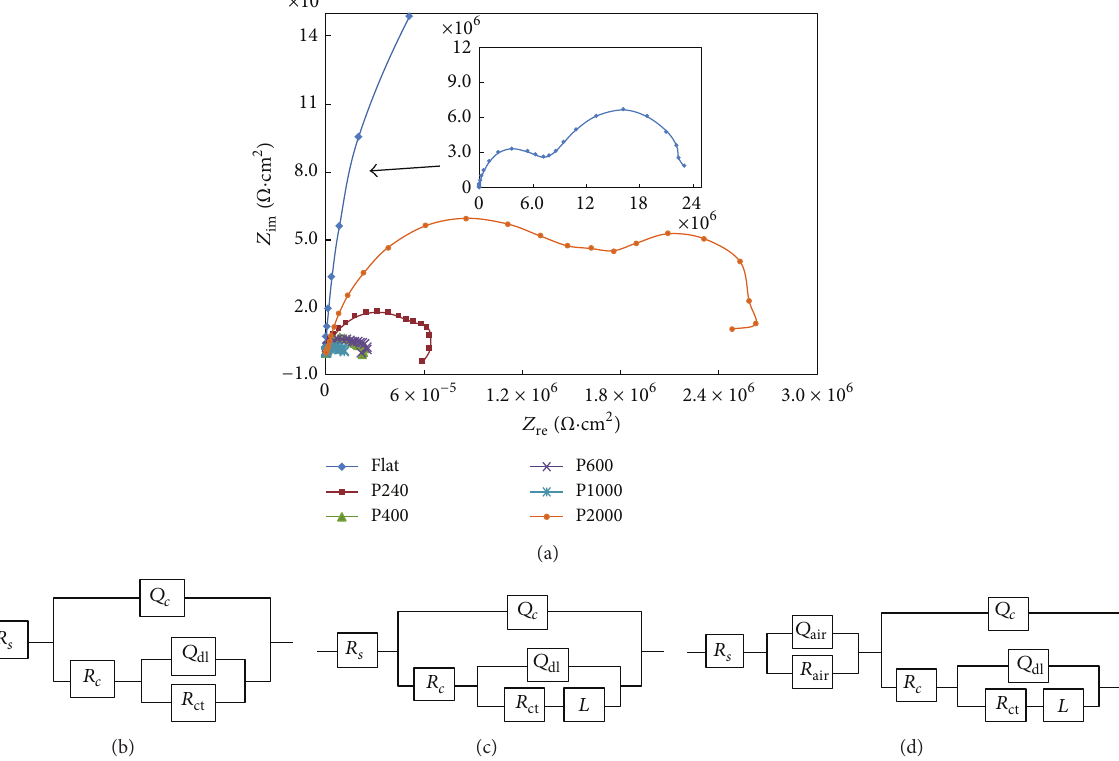
Figure 4: Nyquist plots (a) from EIS measurements and equivalent circuits (b–d) for flat and microstructured